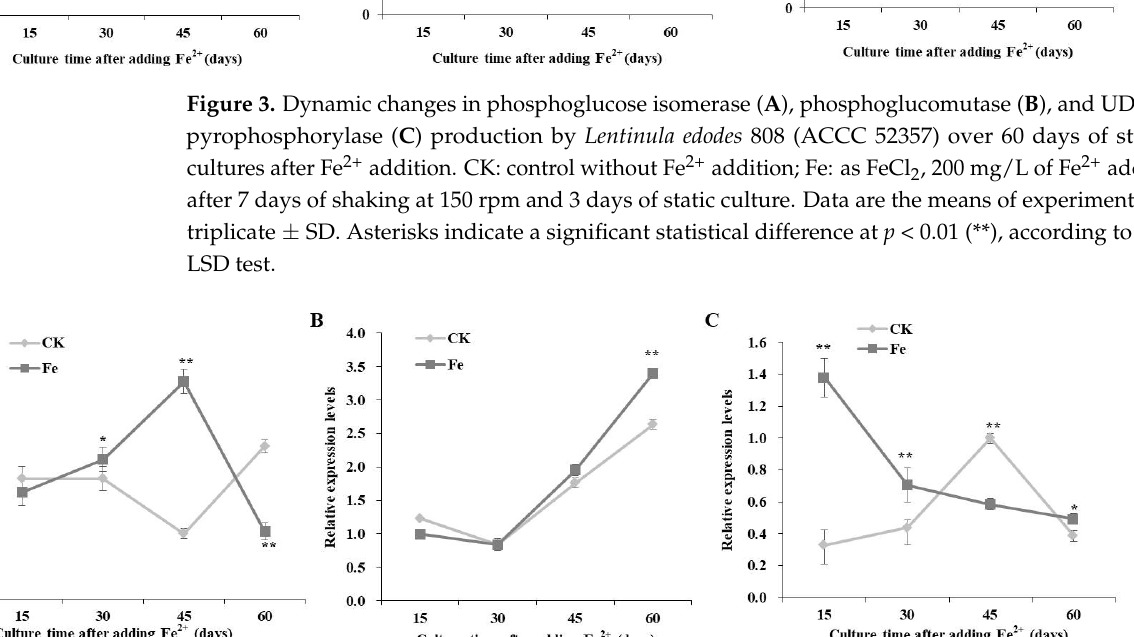
Figure 4. Transcriptional expression levels of pgi ( A ), pgm ( B ), and ugp ( C ) in Lentinula edodes 808 (ACCC 52357) during 60 days of static cultures after Fe 2+ addition. CK: control without Fe 2+ addition ; Fe: as FeCl 2 , 200 mg/L of Fe 2+ added after 7 days of shaking at 150 rpm and 3 days of static culture.